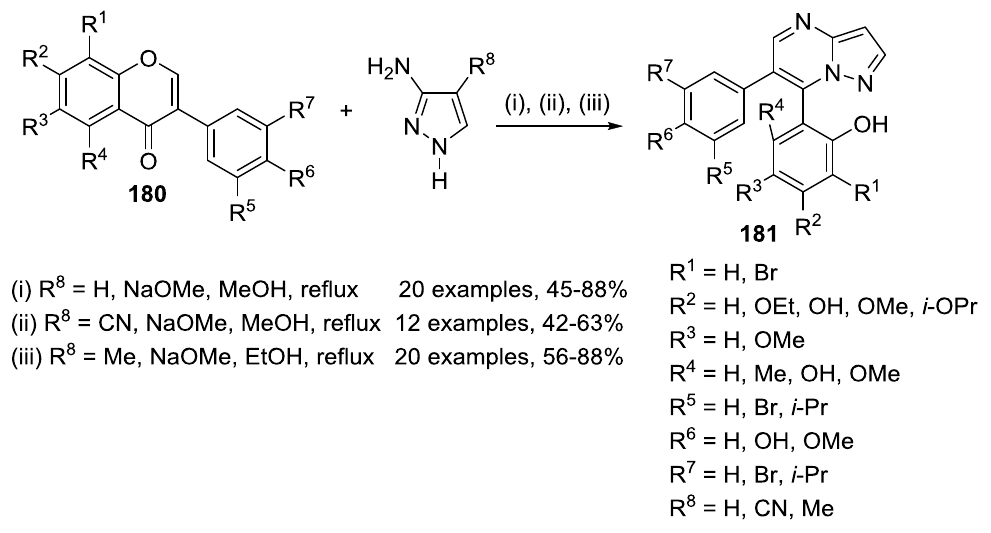
Scheme 63. Transformation of 2-substituted chromone-pyrazole dyads 182 into the corresponding disubstituted 1,2-dihydro-2-iminopyrimidines 183 and 1,2-dihydro-2-pyrimidinethiones 184 [8].